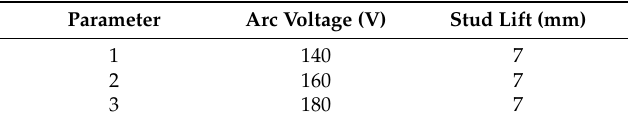
Table 2. Welding parameters of arc stud welding.